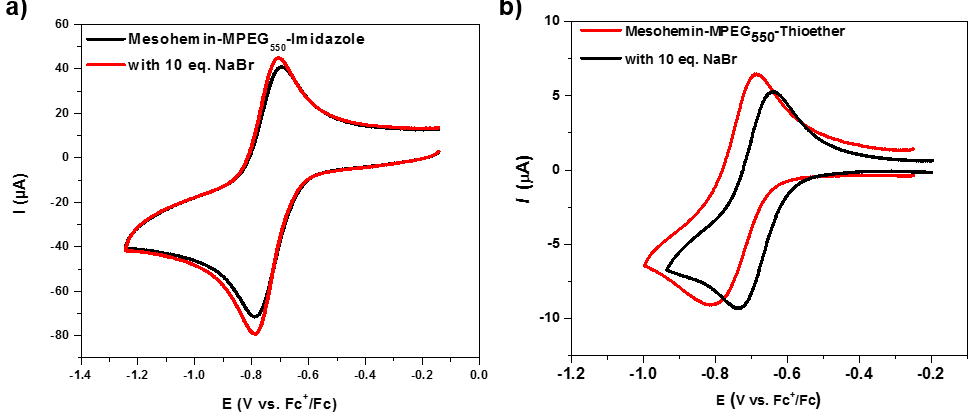
Figure 1. ( a ) Iron porphyrin derivatives used for catalysis of atom transfer radical polymerization (ATRP); ( b ) Scheme of Activator Generated by Electron Transfer (AGET) ATRP of oligo(ethylene oxide) methyl ether methacrylate (OEOMA) 500 .